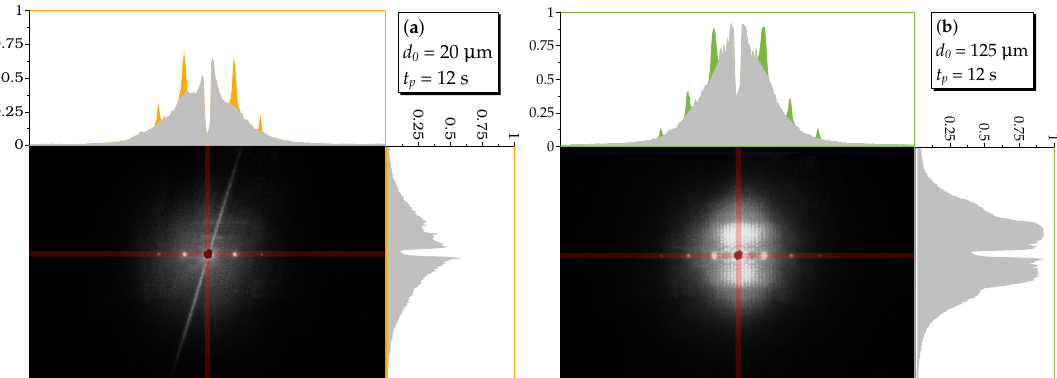
Figure 12. Profiles of the diffraction on top of the holographic scattering patterns for ( a ) d 0 = 20 µ m and ( b ) d 0 = 125 µ m. The scale relates to the intensity averaged over a stripe of 12 pixels (indicated by the faint red color in the photo). Gray shaded areas are due to holographic scattering (PGs), the bright peaks due to diffraction from the elementary gratings. Both photographs were taken with the same exposure time (15 s) and intensity of the readout